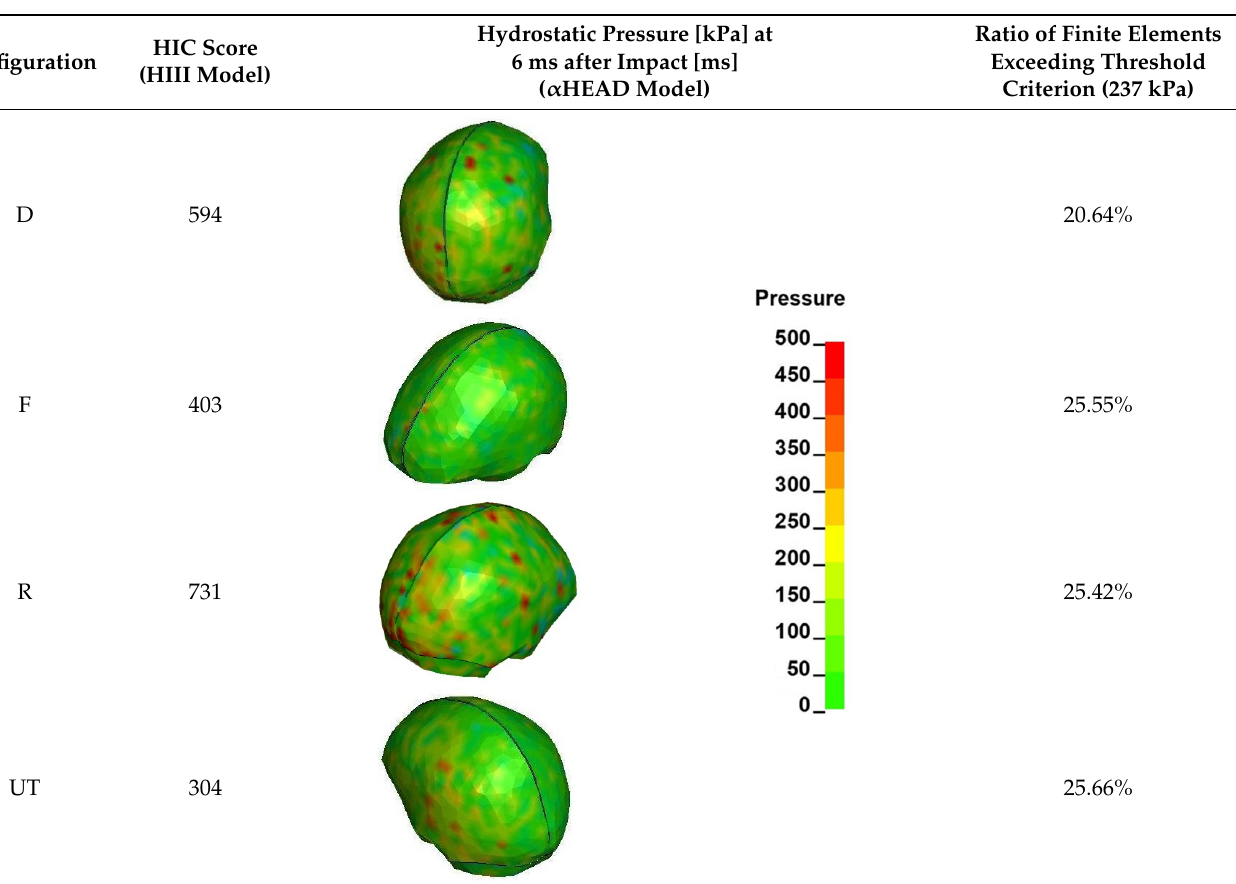
Table 5. Comparison of the HIC score for the Hybrid III dummy to the maximal value of hydrostatic pressure for α Table 5. Cont.